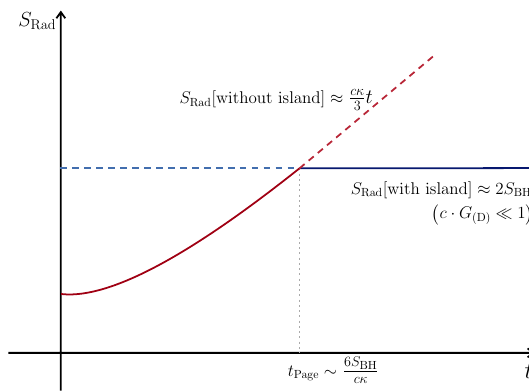
Figure 3. The Page curve for D -dimensional non-extremal spherically symmetric black holes. When the contribution of the island is not considered, the late-time radiation entropy increases linearly (red dashed line); after considering the island’s contribution and the condition c · G the late-time radiation entropy is approximatively saturated at 2 S